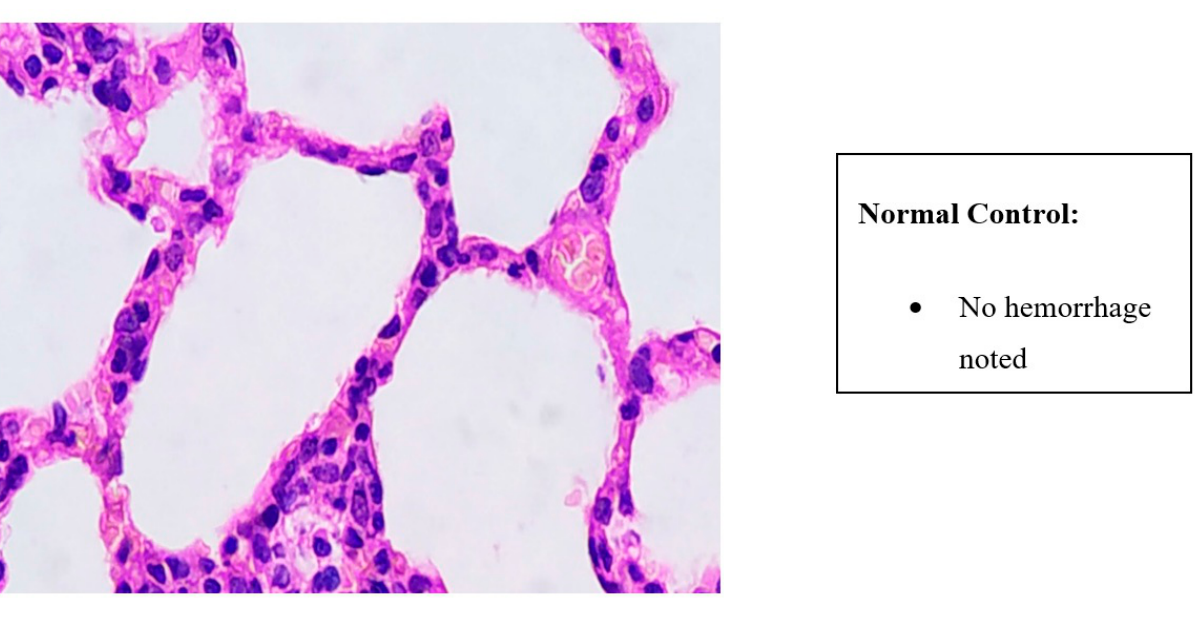
Table 4. Histopathological findings.